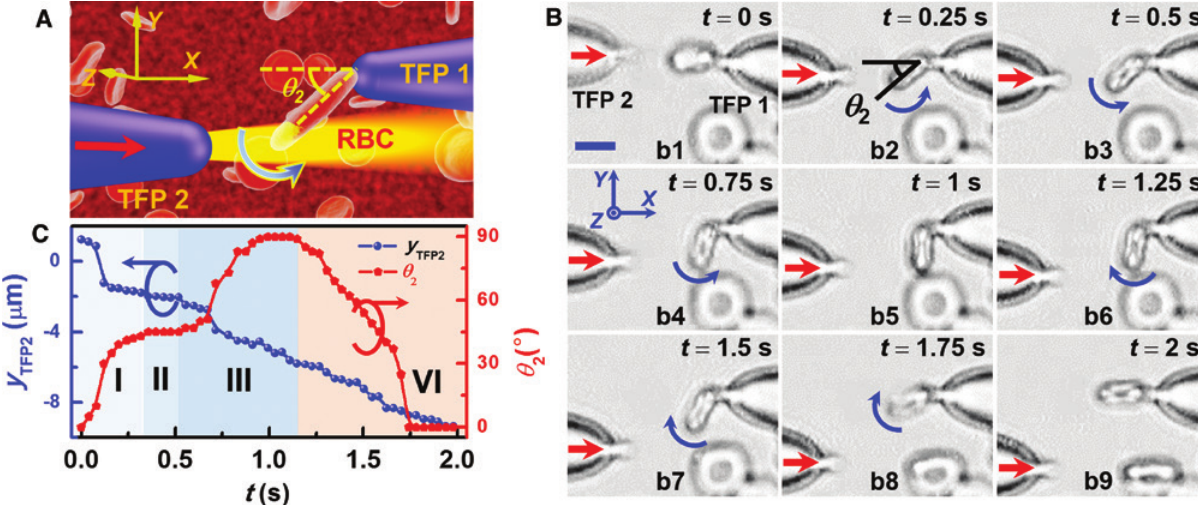
Figure 3: RBC rotation around the z axis. (A) Schematic of RBC rotation around the z axis. (B) Optical microscopic images for rotating an RBC around the z axis. Scale bar: 5 μ m. (C) Calculated y